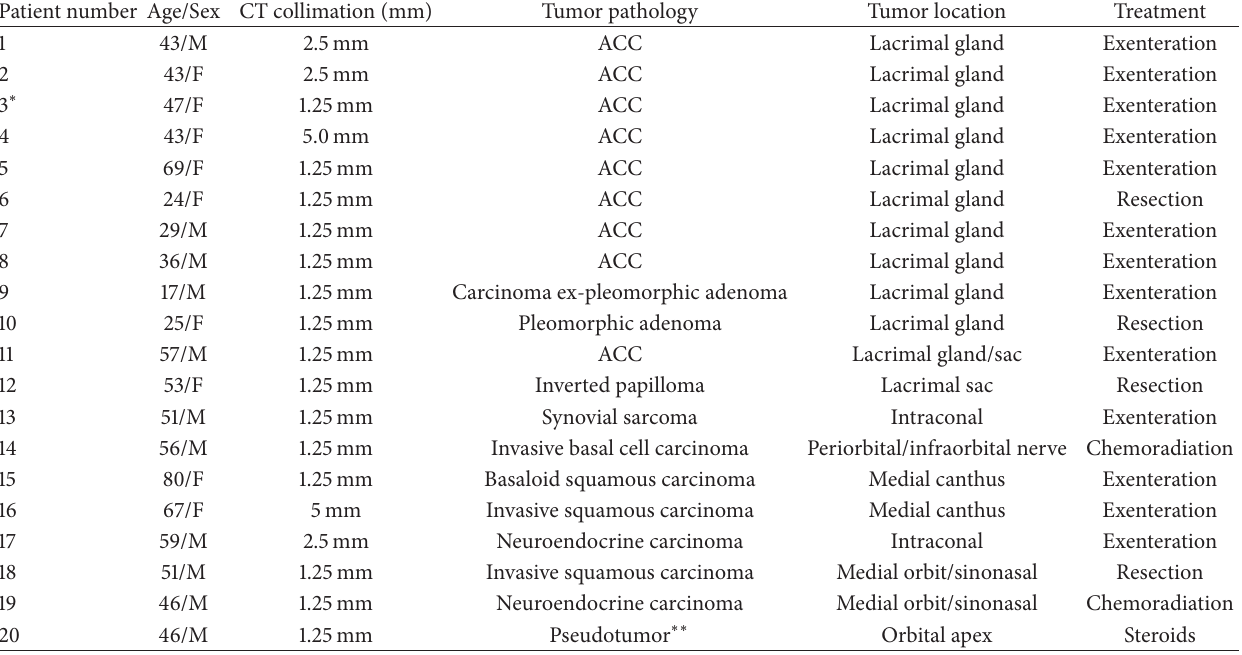
Table 1: Baseline patient demographic and clinical